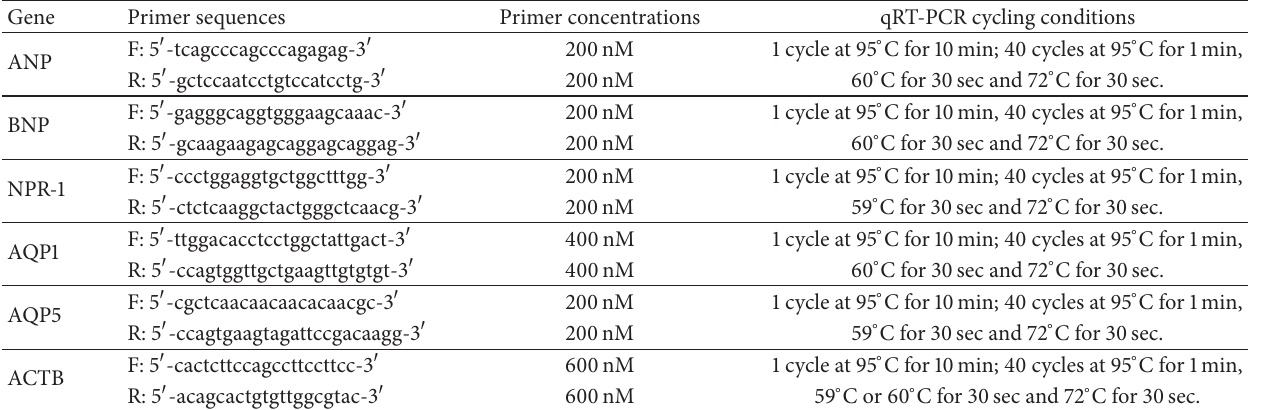
Table 1: Primer sequences, primer concentrations, and qRT-PCR cycling